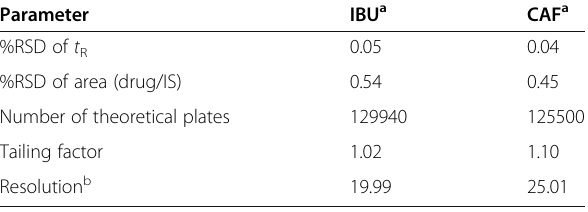
Table 1 System suitability parameters